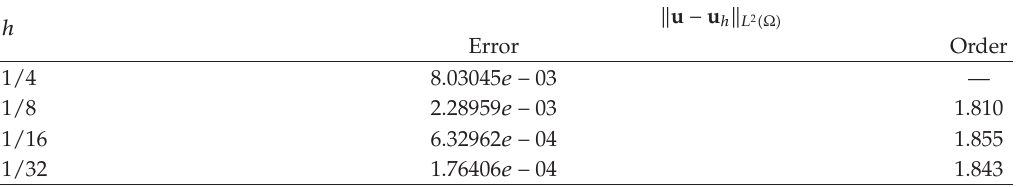
Table 2: L 2 -error and order of convergence in x when μ (cid:8) 1 . 8.